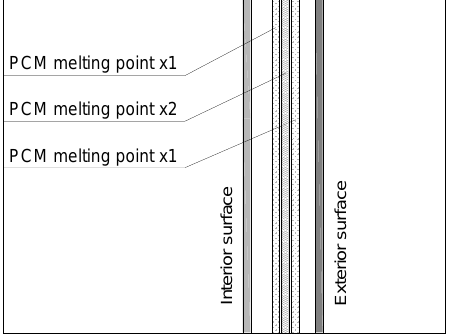
Figure 9. Combination scheme of the PCMs.